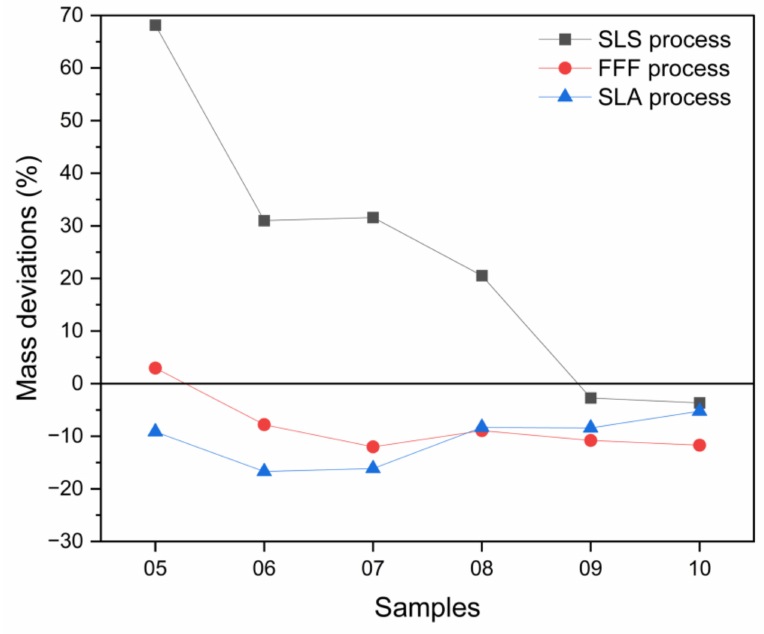
Figure 12. Mass deviations of the samples obtained with the three